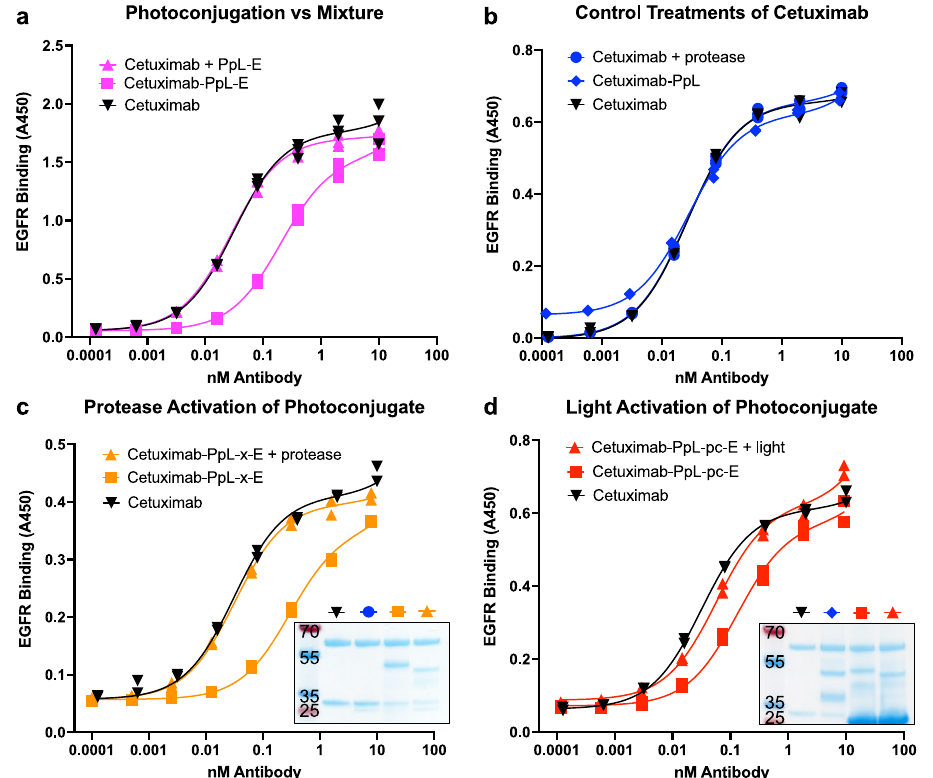
Fig. 3 Protease and light activation of therapeutic cetuximab. a Cetuximab was mixed with blocking peptide linked to wildtype PpL, which binds the light chain transiently (Cetuximab + PpL-E), or was photoconjugated to blocking peptide linked to the R33BpA mutant PpL, which binds the light chain covalently (Cetuximab-PpL-E). Both were compared for af fi nity to EGFR vs cetuximab alone (Cetuximab). The addition of two molar excess PpL-E had no noticeable effect on cetuximab af fi nity indicating the PpL needs to be photoconjugated to effectively block the antibody (K D values – Cetuximab 31 pM, Cetuximab-PpL-E 201 pM, Cetuximab + PpL-E 27pM) ( n = 3). b Protease (chymotrypsin) treatment had no effect on the af fi nity of cetuximab for